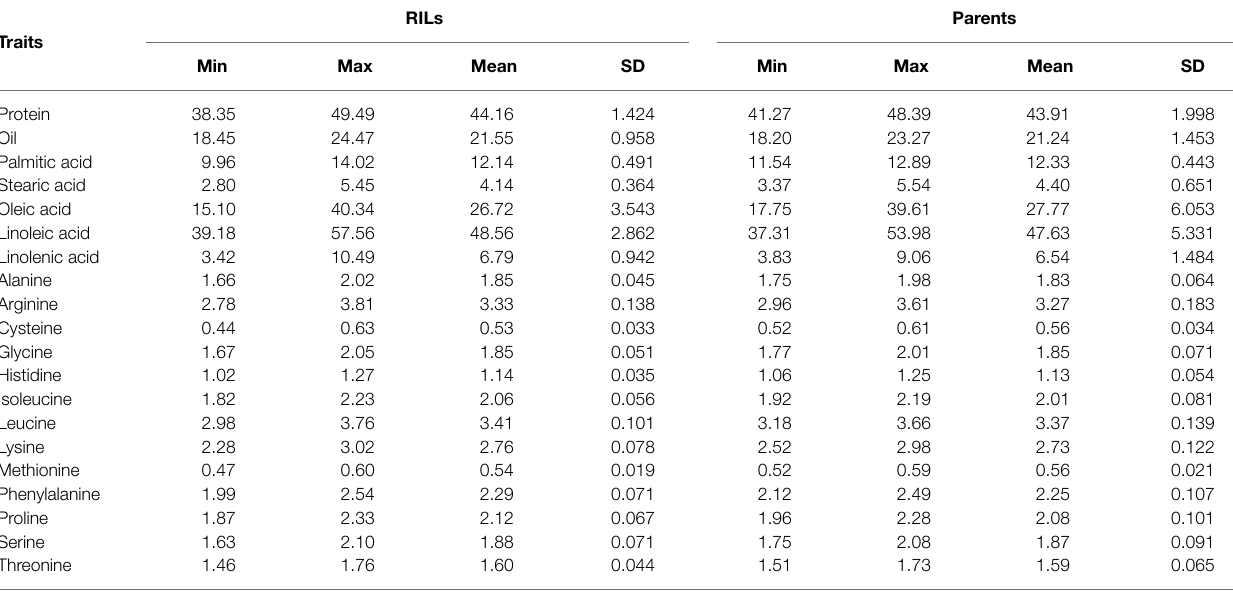
TABLE 2 | Quantitative statistics for seed composition traits of parents and RILs in SoyMAGIC population. Traits